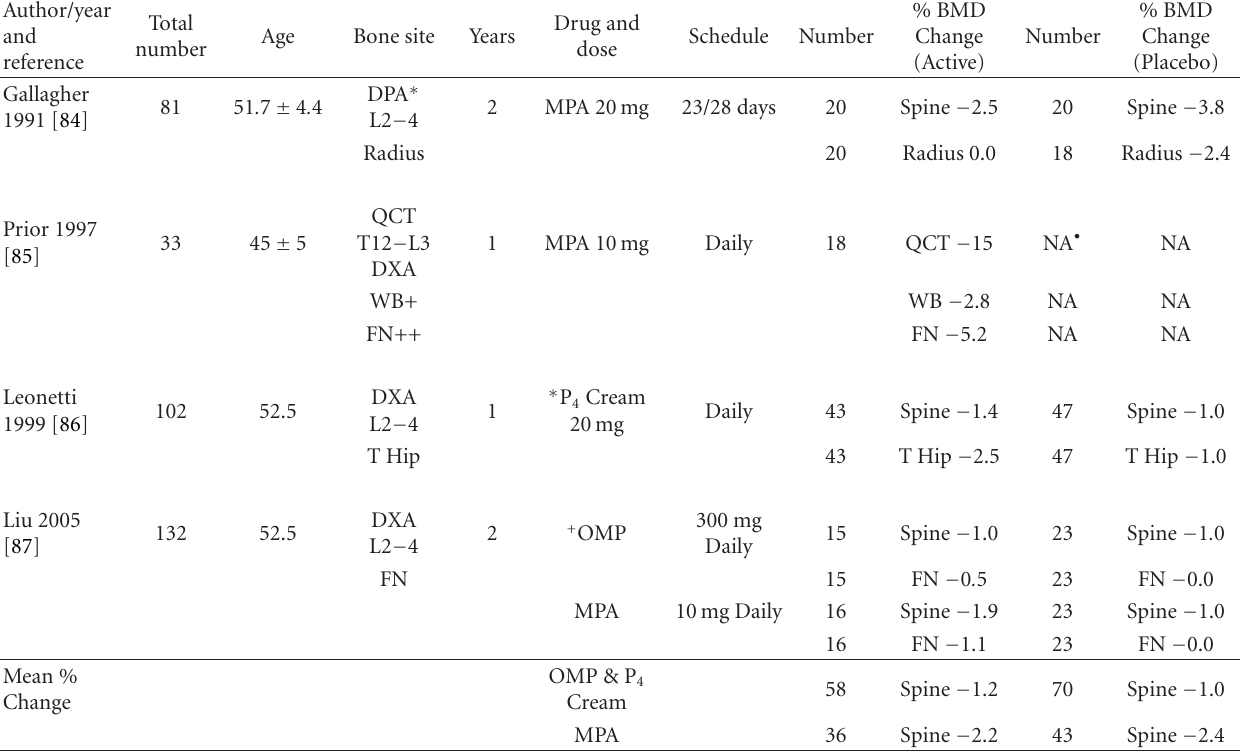
Table 3: Double-blind randomized controlled trials of percentage spine Bone Mineral Density (BMD) change per year in postmenopausal women treated with Progesterone/Medroxyprogesterone (MPA) compared with